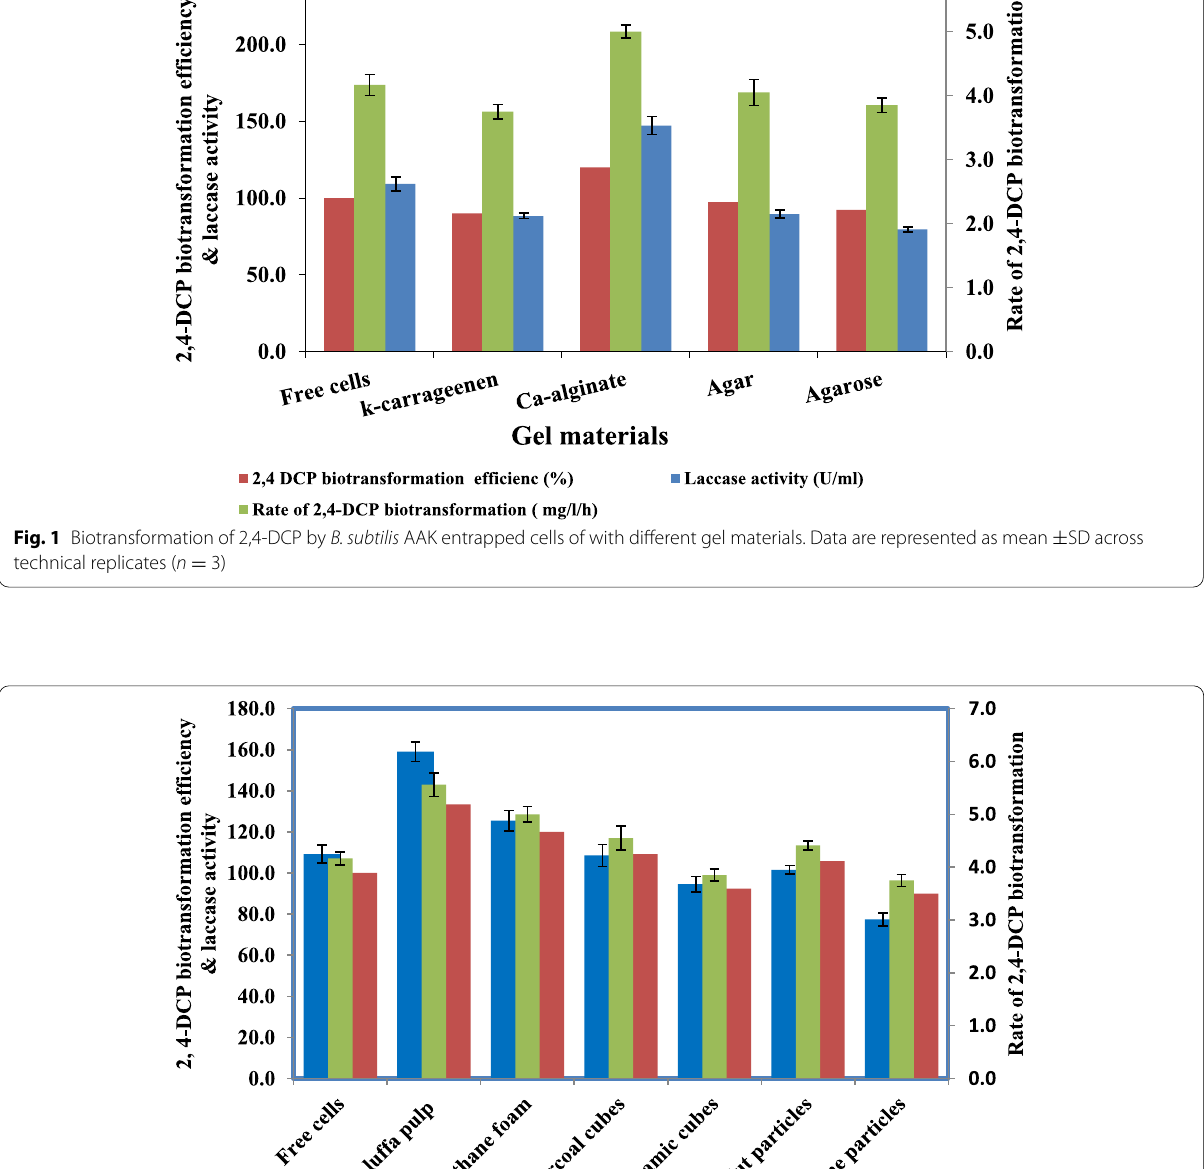
Fig. 2 Biotransformation of 2,4‑DCP by B. subtilis AAK cells adsorbed with different solid supports. Data are represented as mean technical replicates (